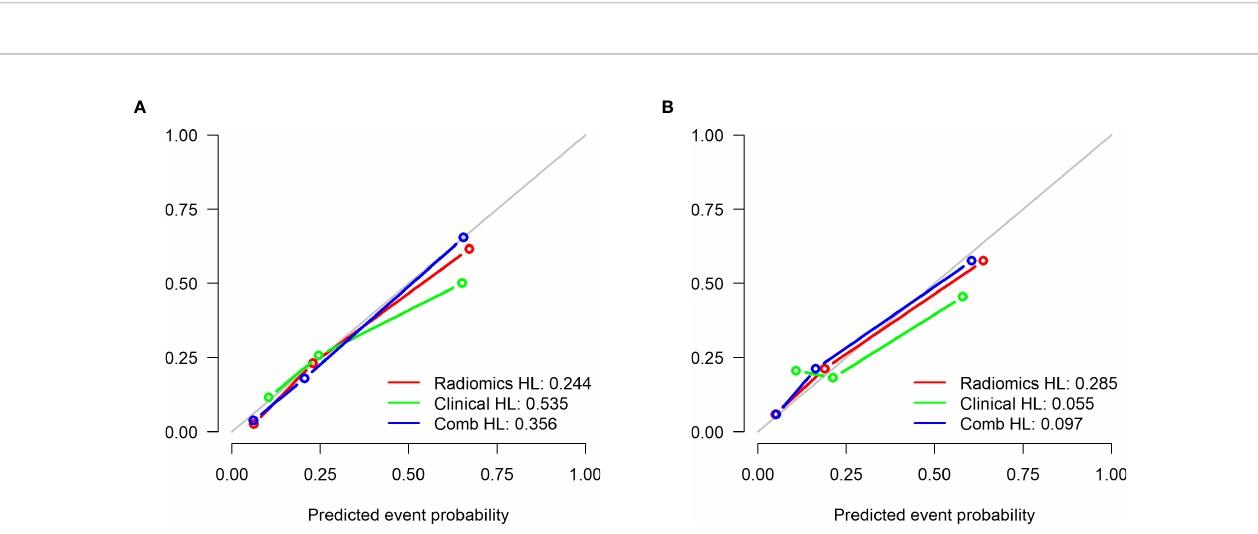
FIGURE 6 | Calibration curves of the 3 models in the training cohort (A) and testing cohort (B) . The 45° gray line indicates perfect prediction and the colored lines the predictive performance of the different models. The closer the line fi t to the ideal line, the better the predictive accuracy of the